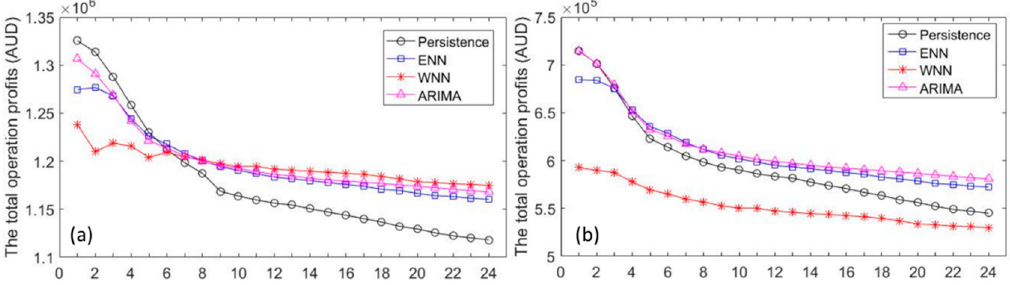
Figure 8. Results of Changing Horizons with ρ US = ρ OS = 1: ( a ) for the Whole Year ( b ) for Normal days.